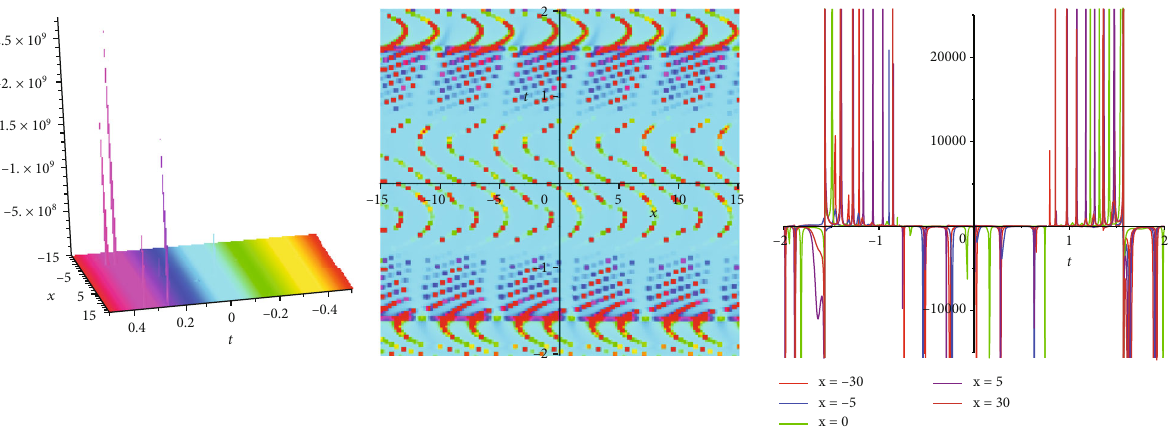
Þ (3D plot, density plot, and 2D plot t ), respectively. 1